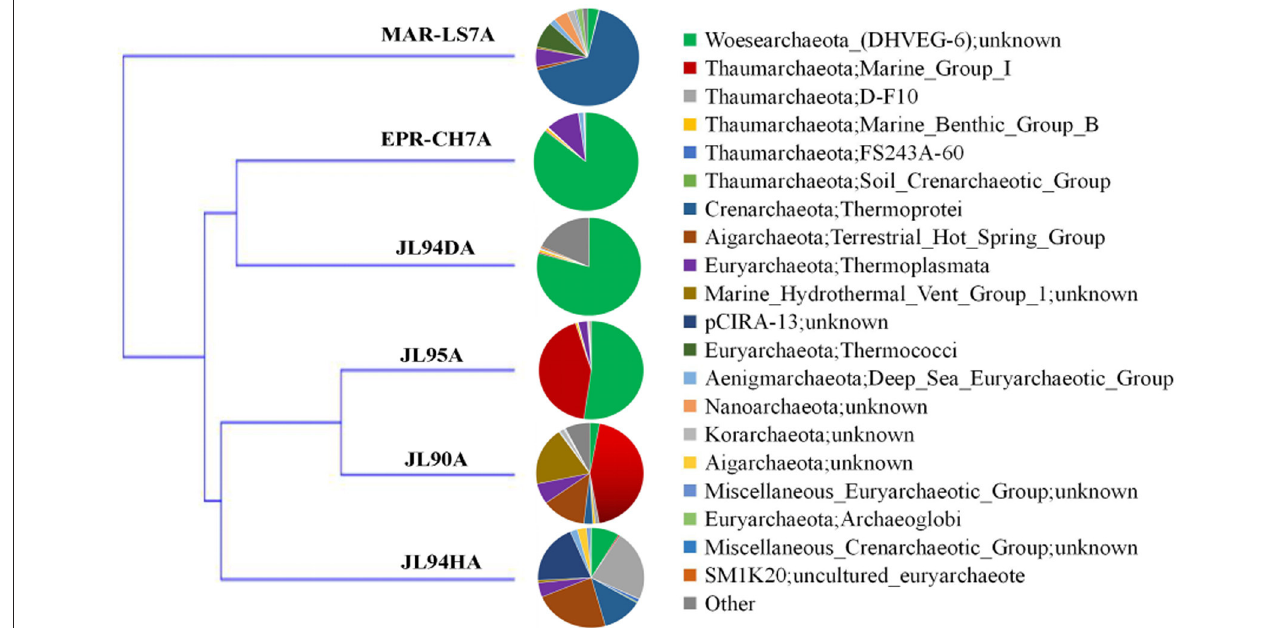
FIGURE 7 | Clustering analysis tree of the archaeal community structure of chimneys from SWIR, EPR and MAR. LS7 = Lucky Strike. Lucky Strike vent field located at MAR (Flores et al., 2011); CH7 = chimney sample from EPR, this study.